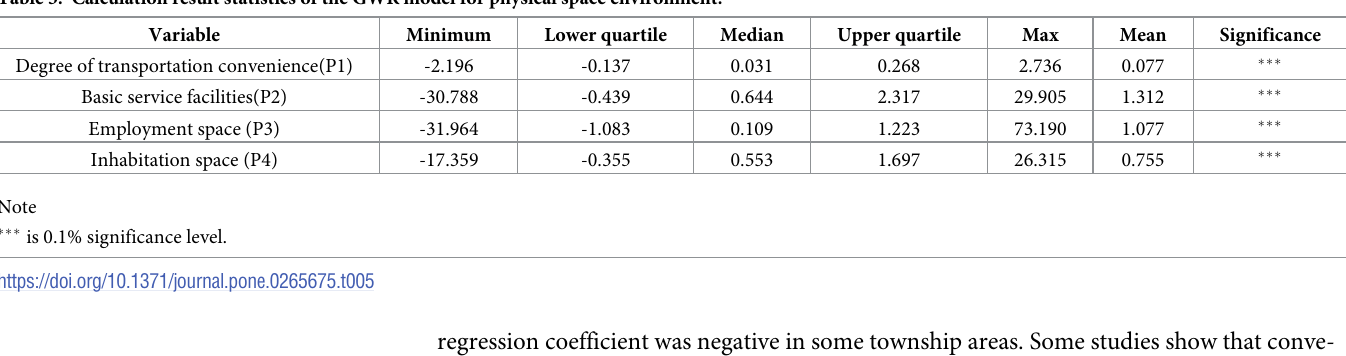
Table 5. Calculation result statistics of the GWR model for physical space environment.